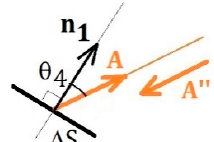
Figure 11. Relationship between unit incident light vector A and unit normal vector n 1 .